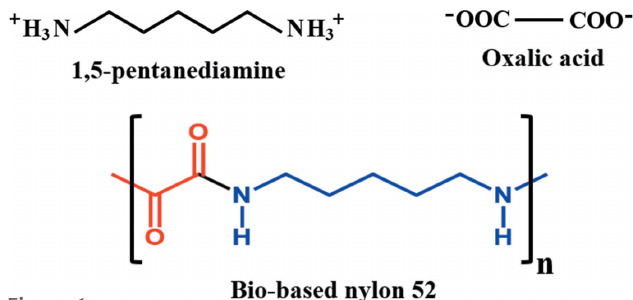
Figure 1 Molecular componentd of 1,5-pentanediamine oxalate (top) and the bio- based nylon 52